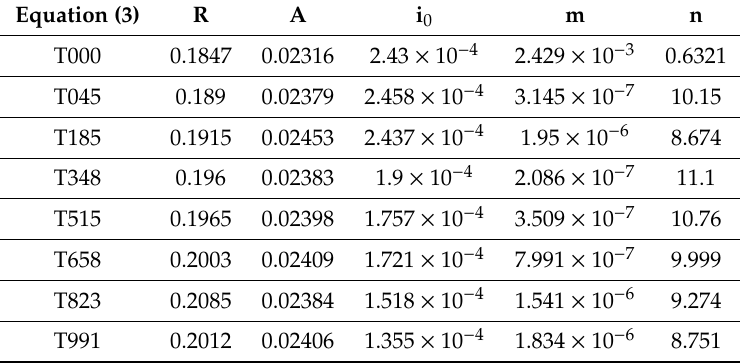
Table 5. Fitted model parameters in Equation (3).